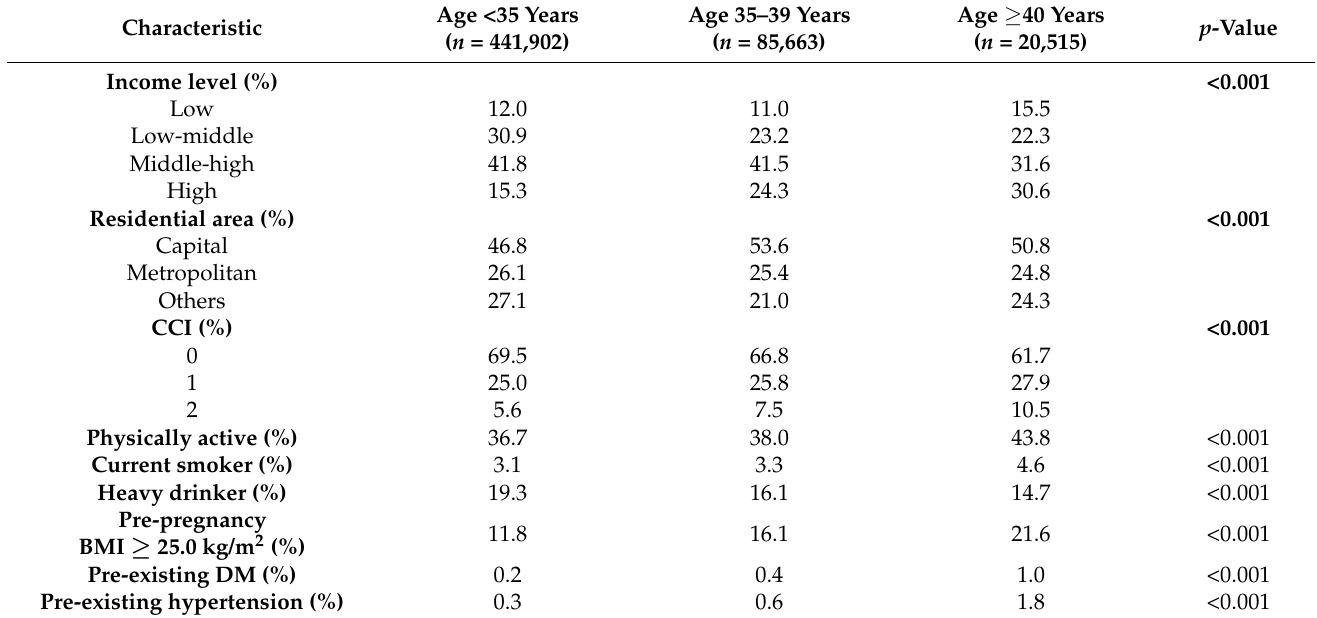
Table 1. Patients’ pre-pregnancy characteristics by maternal